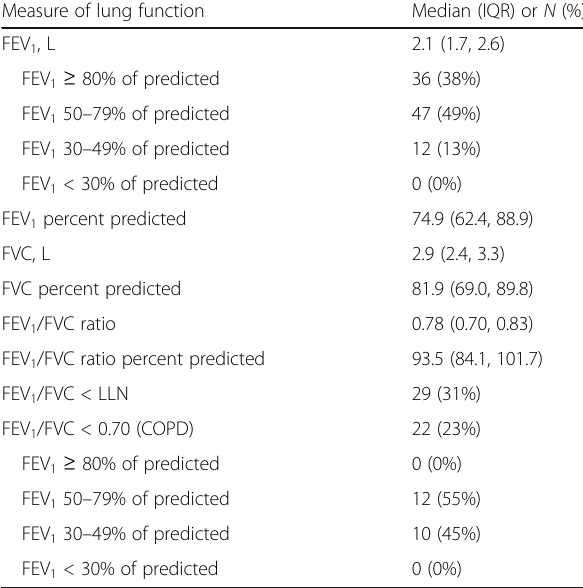
Table 1 Baseline characteristics of study population Table 2 Spirometry results and COPD ( n = 95)